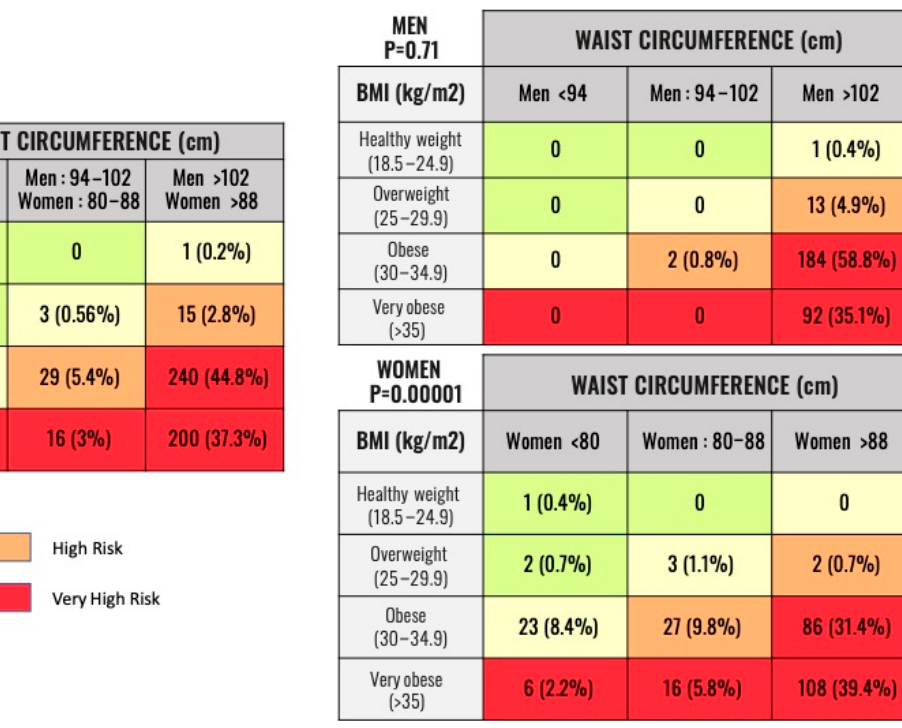
Figure 2. Number and percentage of patients belonging to the categories of Obesity Classification by BMI/WC relationship. Legend: Classification of patients according to metabolic risk. The NICE recommendations have been used based on the value of BMI and WC. The results of the total sample and by gender are shown. BMI: Body Mass Index. WC: Waist Circumference.